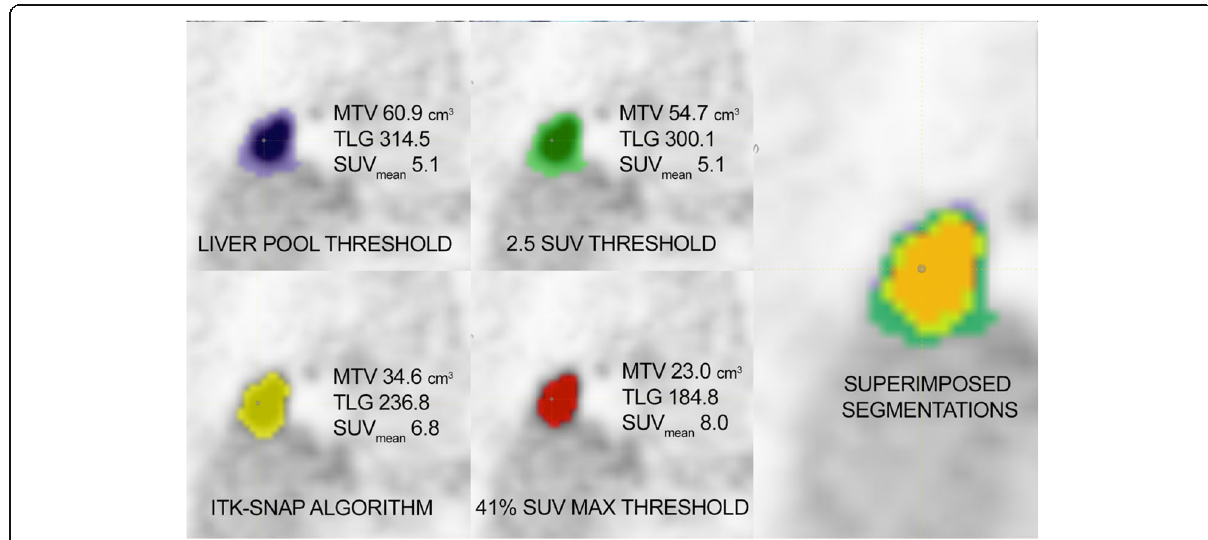
Fig. 1 Different volumes of interest on PET images of a primary lung adenocarcinoma, produced by different segmentation techniques (presented with different colours), resulting in different values of semiquantitative metabolic parameters. MTV Metabolic tumour volume, PET Positron emission tomography, TLG Total lesion glycolysis, SUV mean Mean standardised uptake